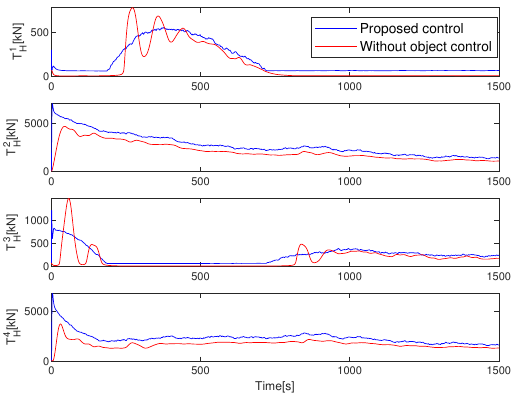
Figure 8. Horizontal tensions along four towlines using two control methods.